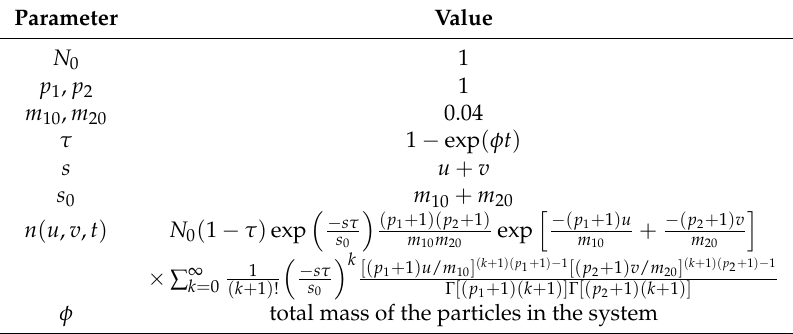
Table 2. Analytical solutions of number density functions for size-dependent